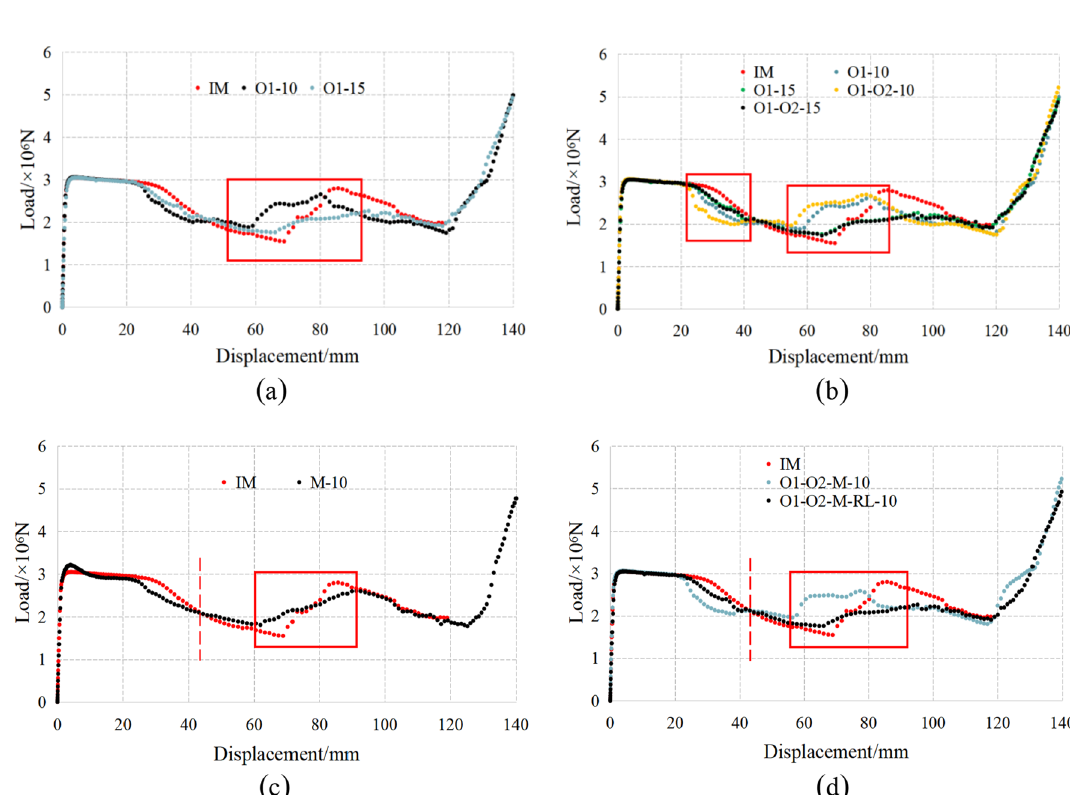
Figure 10. Load displacement